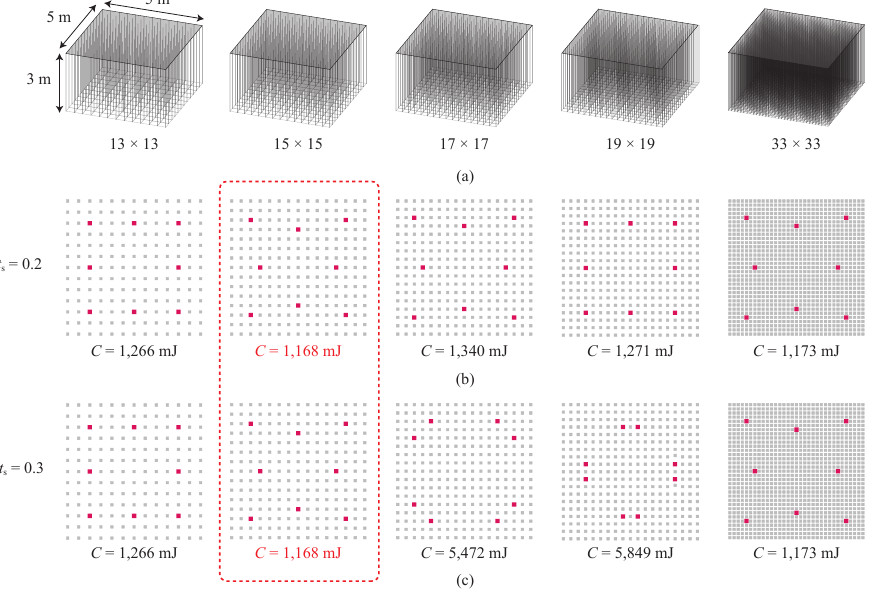
Figure 5. Finding 8 optimal column locations under a square roof. ( a ) Three-dimensional illustration of candidate columns. Optimization results of t s = ( b ) 0.2 and ( c )